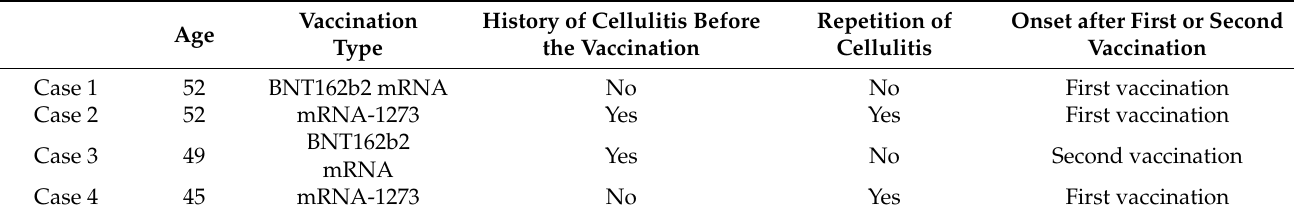
Table 1. Overall characteristics of the